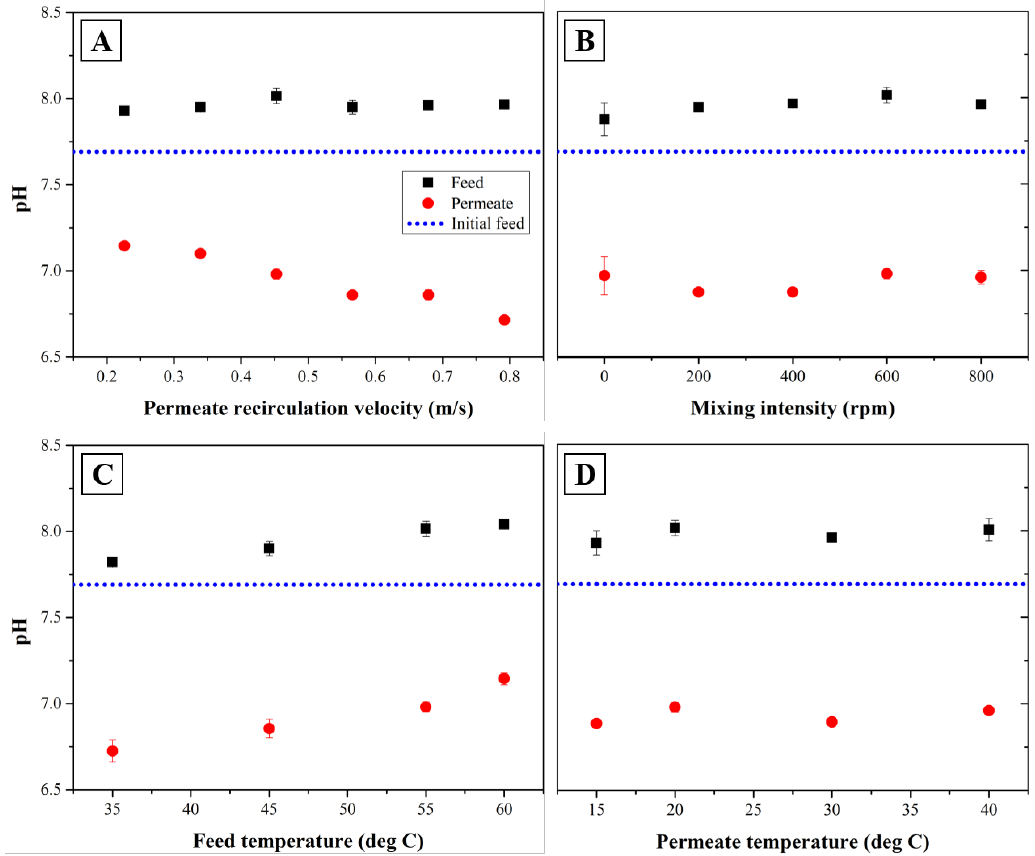
Figure 3. Variations of pH in feed wastewater and permeate after 1 h of operation time with respect to the permeate recirculation velocity (A), mixing intensity (B), feed temperature (C) and permeate temperature (D) (background operational condition; permeate recirculation velocity of 0.5 m/s, mixing intensity of 600 rpm, feed temperature of 55 °C and permeate temperature of 20 °C).